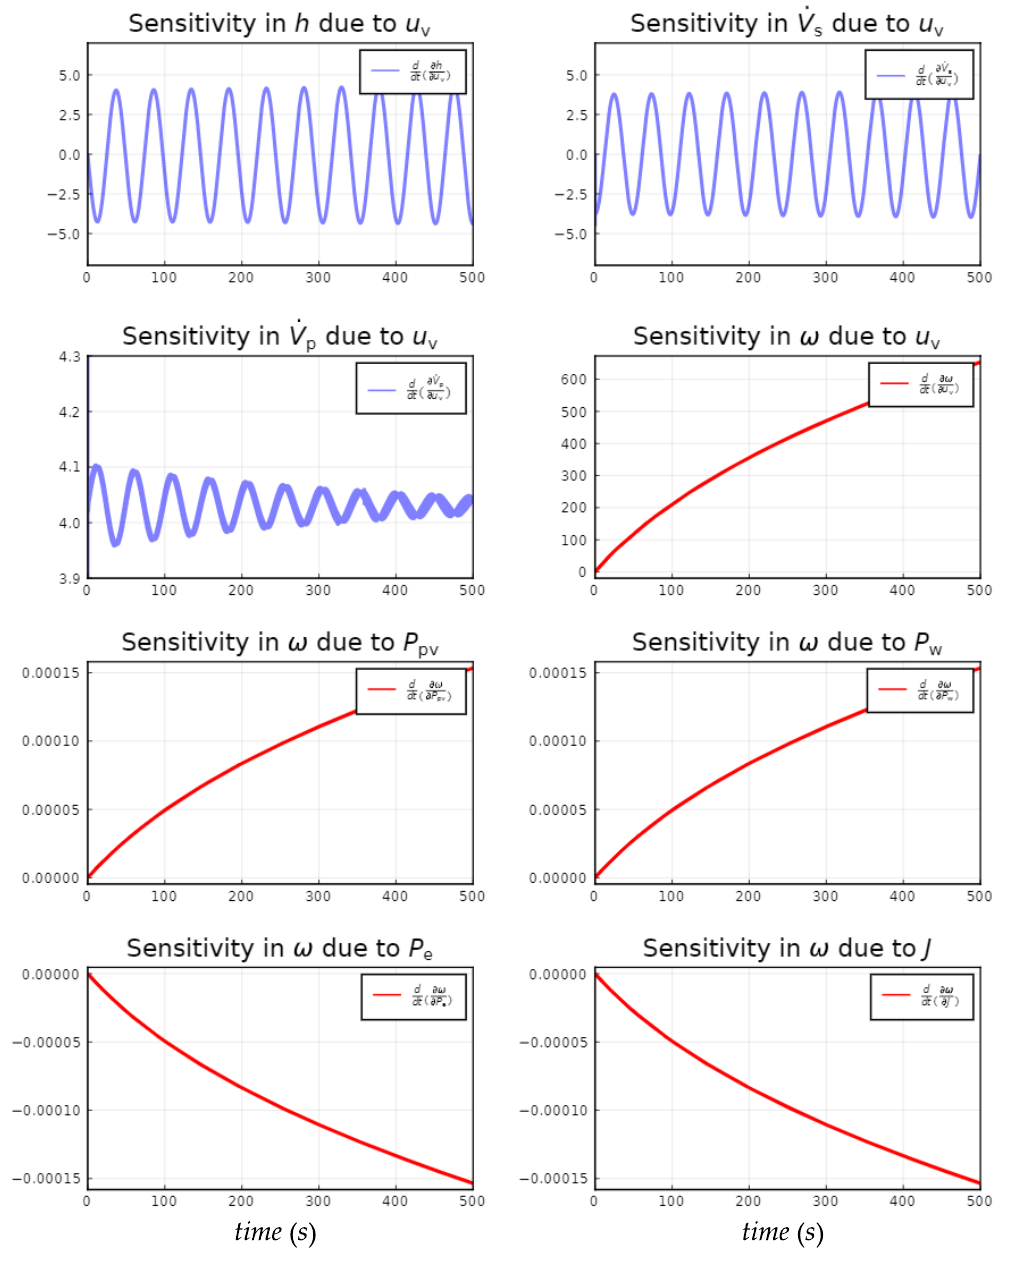
Figure 4. Local parameter sensitivity